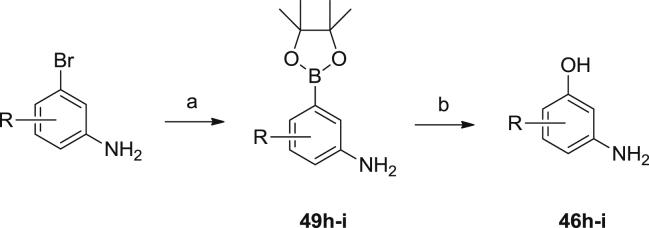
Synthesis of anilinophenols via boronate oxidation. aReagents and conditions: (a) Pd(dppf)Cl2·DCM, bis(pinacolato)diboron, 1,4-dioxane; (b) sodium perborate, THF, water.